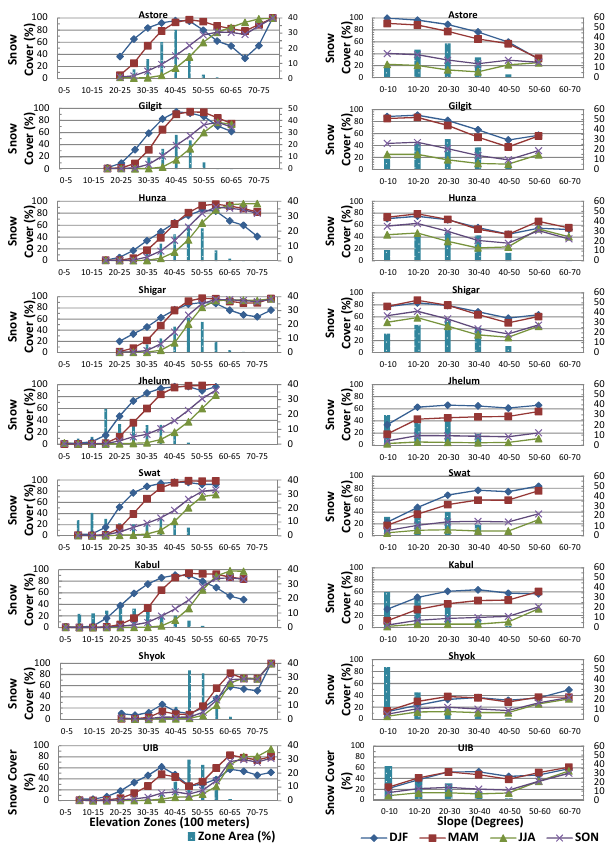
Figure 11. Snow cover against elevation (left panels) and slope (right panels) zones along with zone